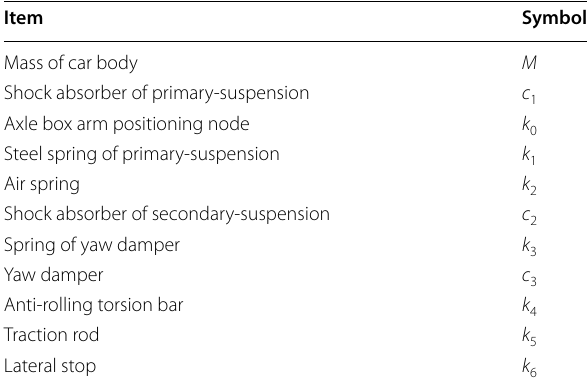
Table 2 Symbolic description of the vehicle dynamic